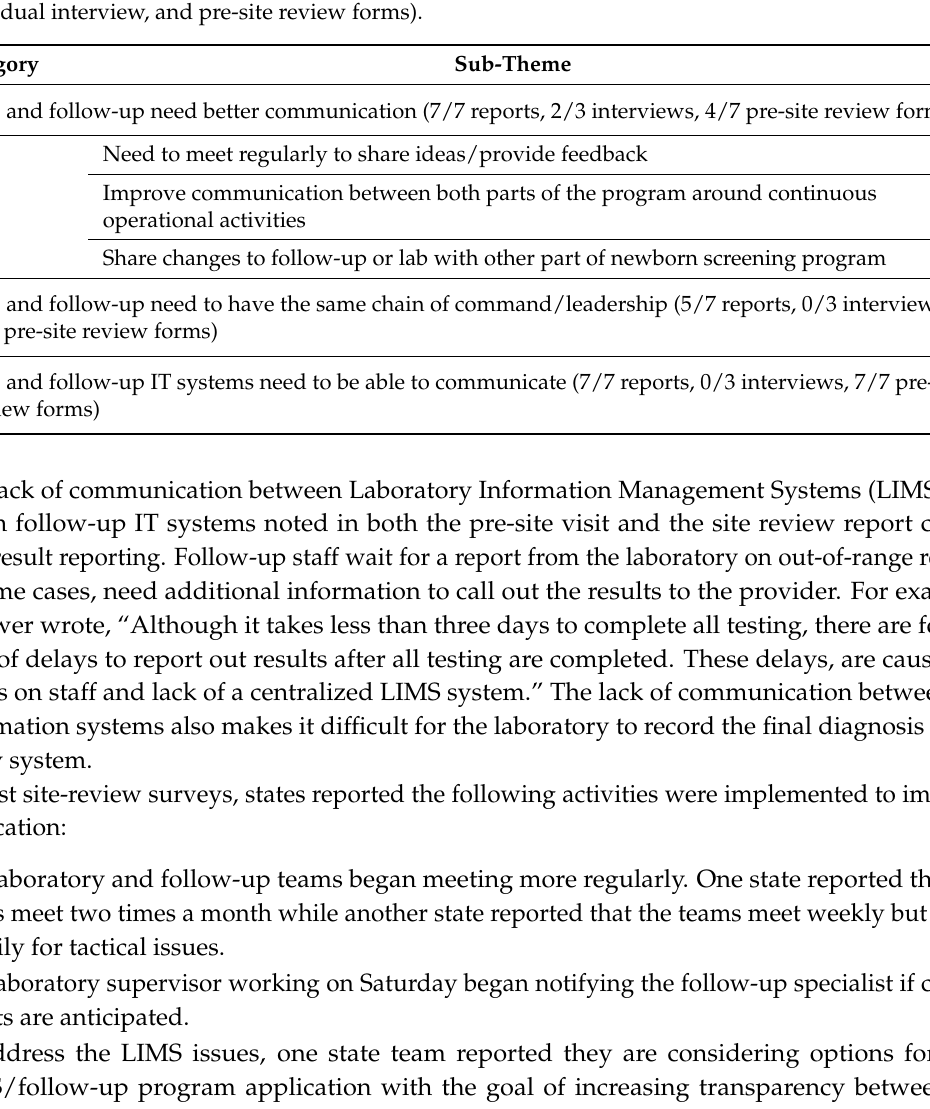
Table 1. Needs identified in State Newborn Screening Program Site Reviews: Communication within the Newborn Screening Program: themes identified (Number of times reported in site review report, individual interview, and pre-site review